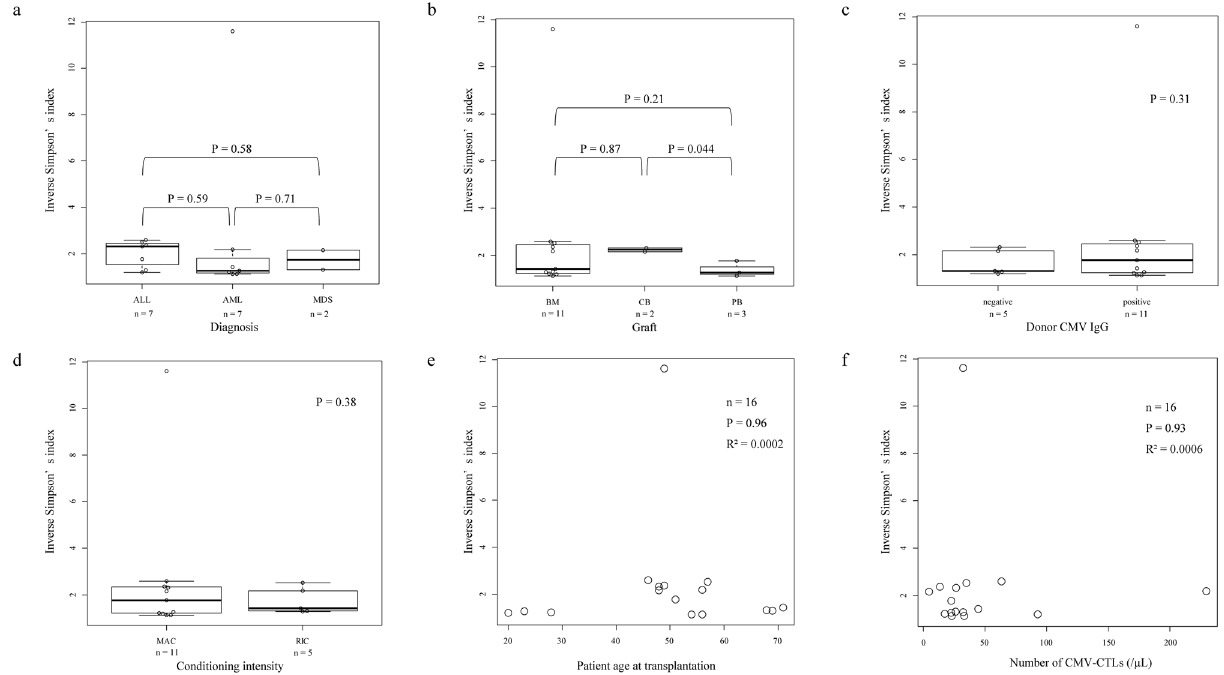
Figure 2. Associations between the diversity of T-cell receptor (TCR)-beta repertoire of cytomegalovirus- specific cytotoxic T-cells (CMV-CTLs) and clinical characteristics. Association between TCR repertoire diversity and ( a ) diagnosis of hematological diseases, ( b ) graft source, ( c ) donor CMV serology, ( d ) conditioning intensity, ( e ) recipient age at transplantation, and ( f ) the number of CMV-CTLs at CMV reactivation.